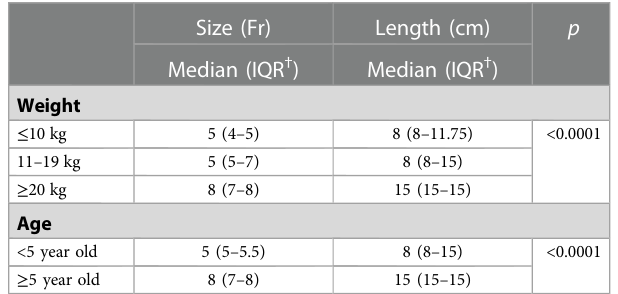
TABLE 5 Variables related to CD34+cells collected per body